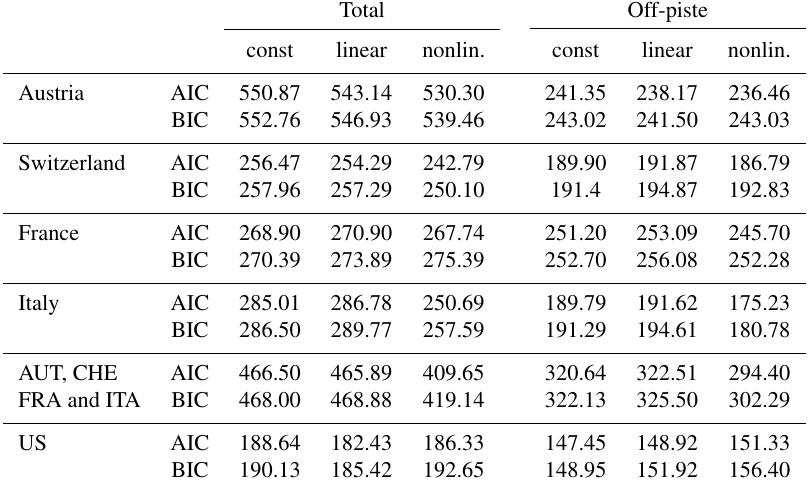
Table 2. AIC and BIC of the constant, linear and nonlinear trend model considering data of Austria total and off-piste (Figs. 1 and 2); Switzerland total and off-piste (Fig. 3); France total and off-piste (Fig. 4); Italy total and off-piste (Fig. 5); summing-up of AUT, CHE, FRA and ITA total and off-piste (Fig. 7); and US total and off-piste (Fig.